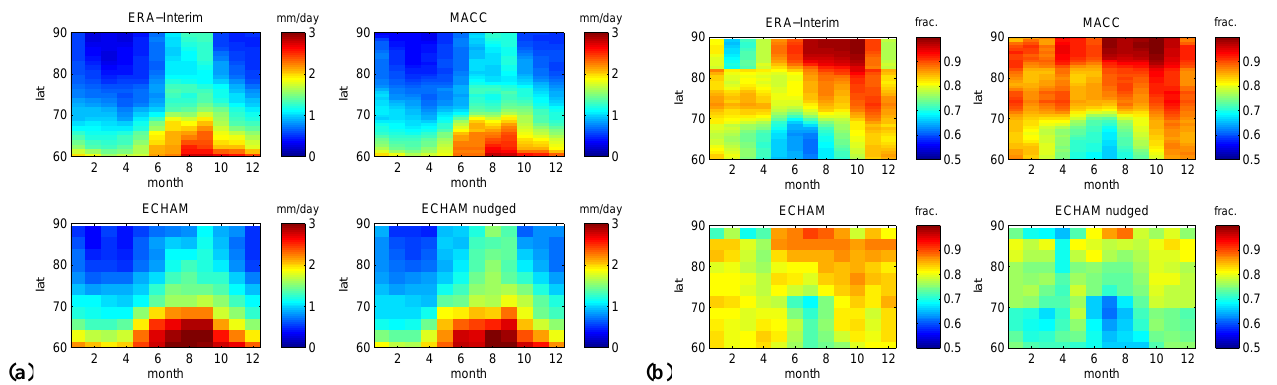
Fig. 2. Zonal averages of precipitation and total cloud cover as a function of month and latitude for models and reanalyses used in this study. The total precipitation fields are monthly averaged in the period 2003-2006 (common to all datasets) for ERA-Interim, MACC, ECHAM (the EAERO run) and for ECHAM nudged to ERA-Interim (EAERO). (a) Total precipitation. (b) Total cloud cover